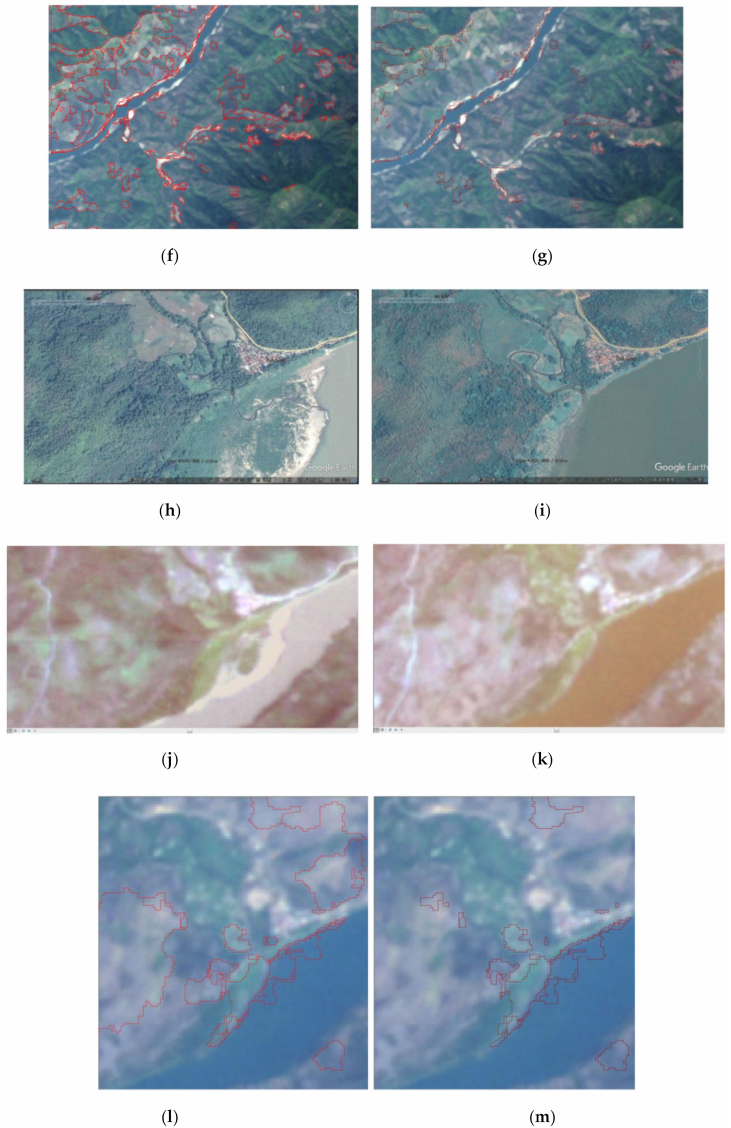
Figure 17. ( a ) Location of two small areas, ( b ) Area 1 Google Earth image of February 2016, ( c ) Area 1 Google Earth image of February 2020, ( d ) Area 1 GF-1 image of February 2016, ( e ) Area 1 GF-1 image of February 2020, ( f ) Area 1 changed patches before spurious change removal, ( g ) Area 1 changed patches after spurious change removal, ( h ) Area 2 Google Earth image of February 2016, ( i ) Area 2 Google Earth image of February 2020, ( j ) Area 2 GF-1 image of February 2016, ( k ) Area 2 GF-1 image of February 2020, ( l ) Area 2 changed patches before spurious change removal, ( m ) Area 2 changed patches after spurious change